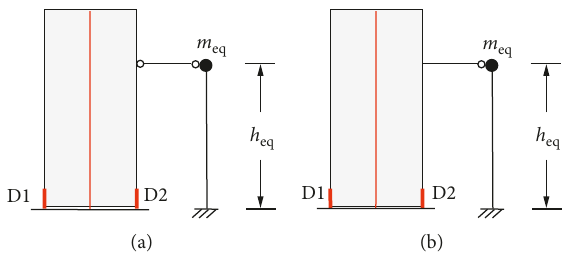
Figure 3: Conversion of a MDOF system into an equivalent SDOF system.